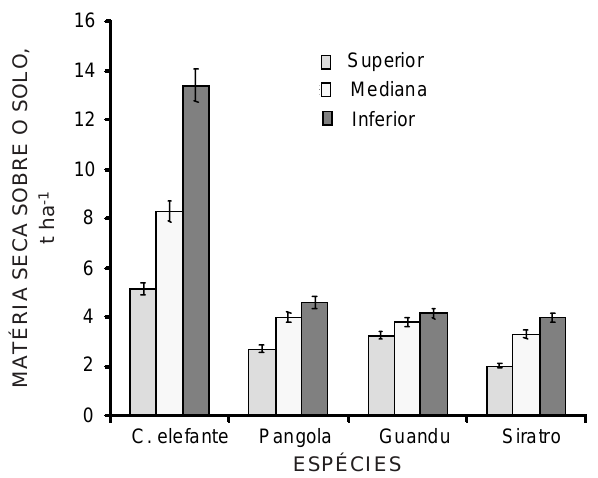
Figura 1. Quantidades de matéria seca sobre o solo depositadas pelas espécies analisadas no decorrer de dois anos, coletadas em três posições de cada parcela ao longo do declive. As barras verticais indicam o desvio-padrão da